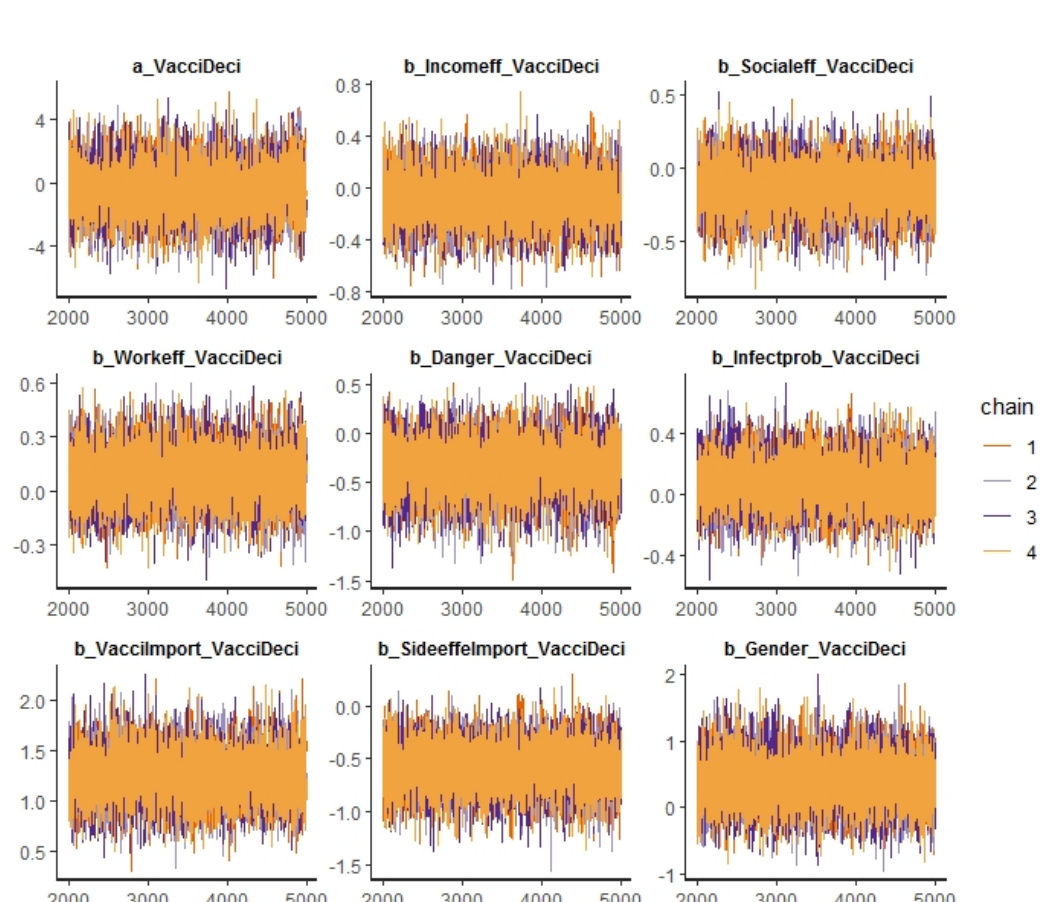
Figure 5. The MCMC chains for the Bayesian model of vaccination decision.